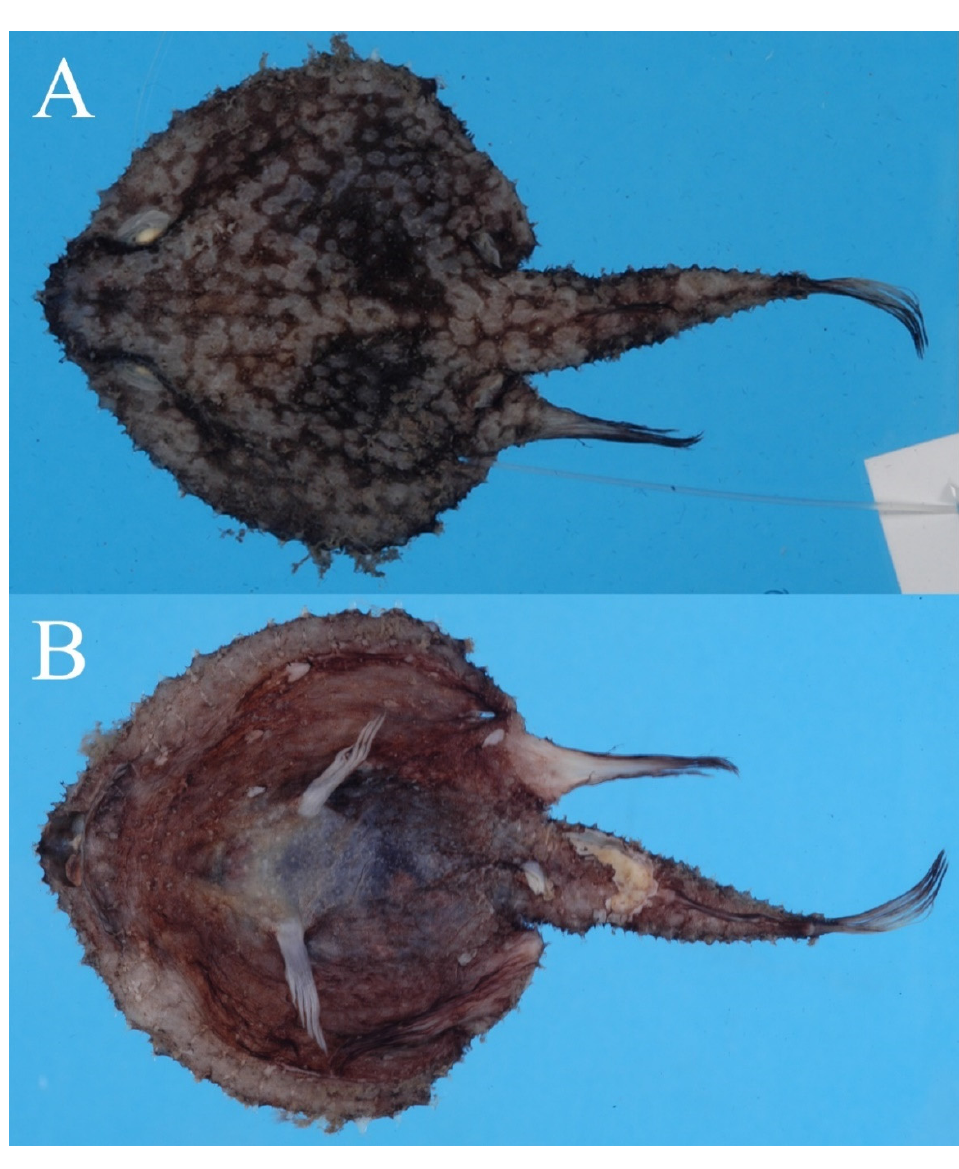
Figure 7. Halieutopsis echinoderma sp. nov., Holotype, ASIZP 62587, 60.2 mm SL, northeastern Taiwan, fresh. ( A ). Dorsal view. ( B ). Ventral view.